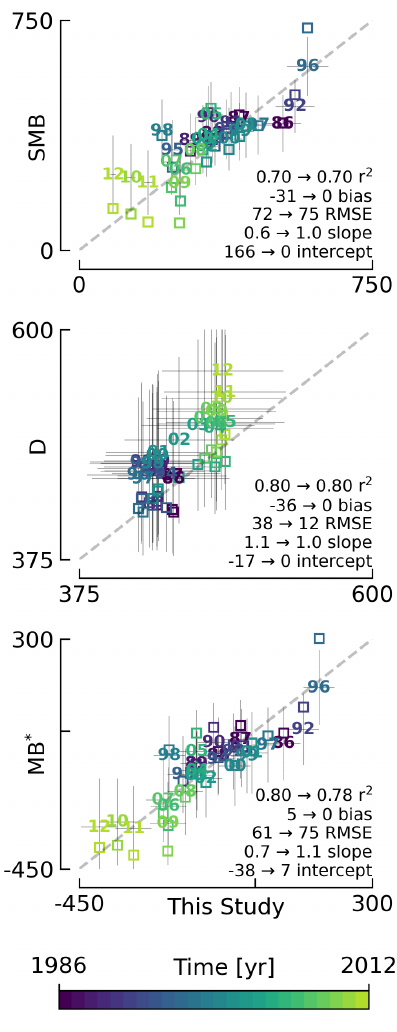
Figure 3. Comparison between This Study and the reconstruction (Kjeldsen et al., 2015). All axis units are Gtyr − 1 . Plotted numbers represent the last two digits of the years for the unadjusted data sets. The matching colored squares show the adjusted data. MB ∗ shown here does not include BMB for either the reconstructed or This Study data. Arrows show statistical properties before and after the adjustment. No adjustment is made to MB ∗ , but it is computed from Eq. (4) both before (numbered) and after (squares) the surface and discharge